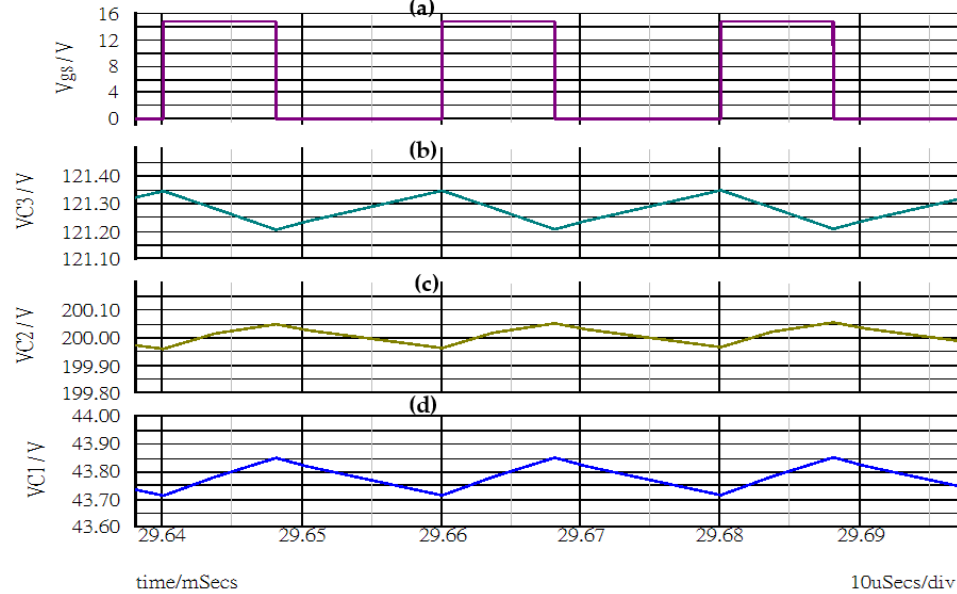
Figure 16. Simulated waveform of ( a ) duty cycle (V gs ) at duty d = 0.402, ( b ) Capacitor (C 3 ) voltage